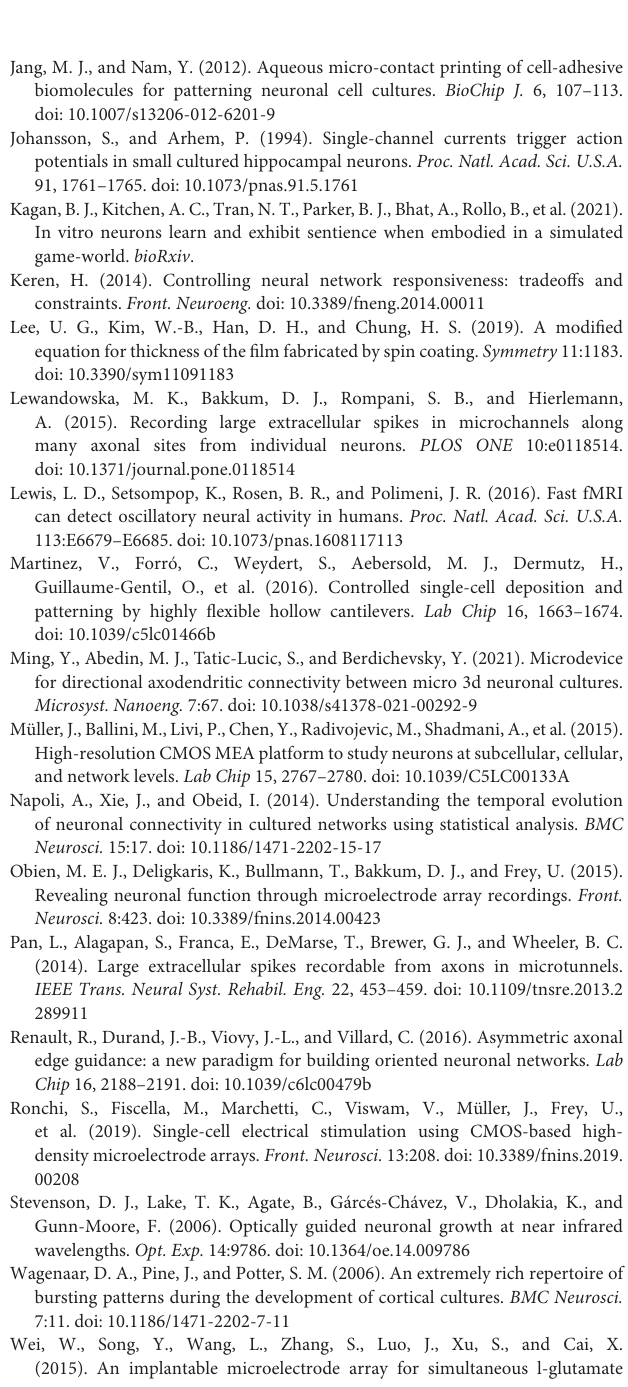
Supplementary Datasheet 3 | SEM image of a recessed electrode on the CMOS chip surface with indicated projected trench height. Supplementary Datasheet 4 | (A) Impedance map of the circular four node structures mounted onto the CMOS array. (Bi) Corresponding electrode blocks